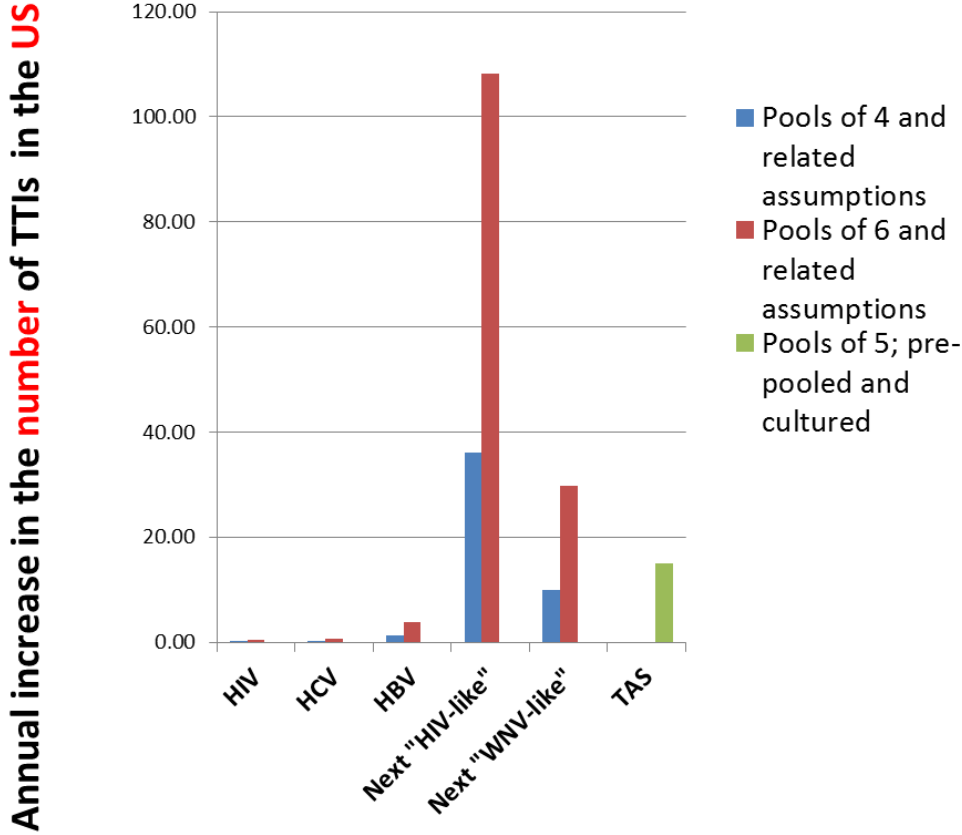
FIGURE 2. Annual increase in the number of TTIs contracted in the U.S. because of the 1.080 million preventable allogeneic-donor exposures that result from the continued transfusion of 12.5% of platelet doses as pooled (rather than single-donor) platelets[10]. Because competing assumptions were involved in the calculations (Table 1), each pair of columns for the HIV, HCV, or HBV infection, as well as infection with the next ―HIV-like‖ or ―WNV-like‖ (see text) transfusion-transmitted pathogen to emerge in the U.S., corresponds to the two ends of the plausible range[4]. The preventable transmissions of HIV, HCV, or HBV infection are due to ―window-period‖ infections. Observed numbers of known TTIs do not approach these modeled estimates, either because transmissions are under-recognized or under-reported with current surveillance, or because the assumptions made in the published models[7] are overly conservative. The depicted annual risk of TABS reflects the situation in the U.S. as of January 31, 2011 when bacterial culture of PWBD platelets was implemented. Abbreviations used in the figure: HIV = human immunodeficiency virus; HCV = hepatitis C virus; HBV = hepatitis B virus; TAS = transfusion-associated bacteremia/sepsis; WNV = West Nile